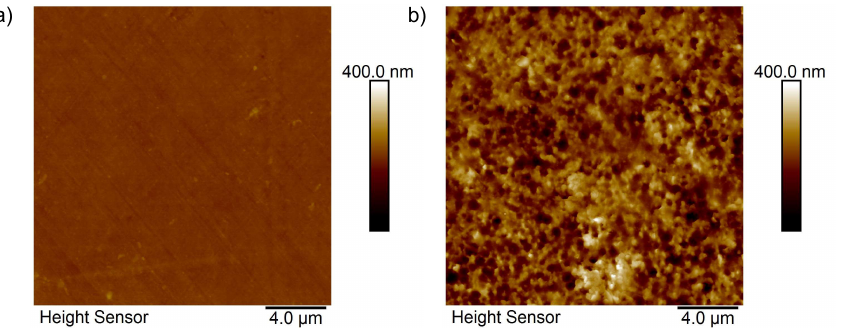
Figure 5. PeakForce Tapping mode AFM images of the control PET surface ( a ) and PET*96 h surface ( b ).